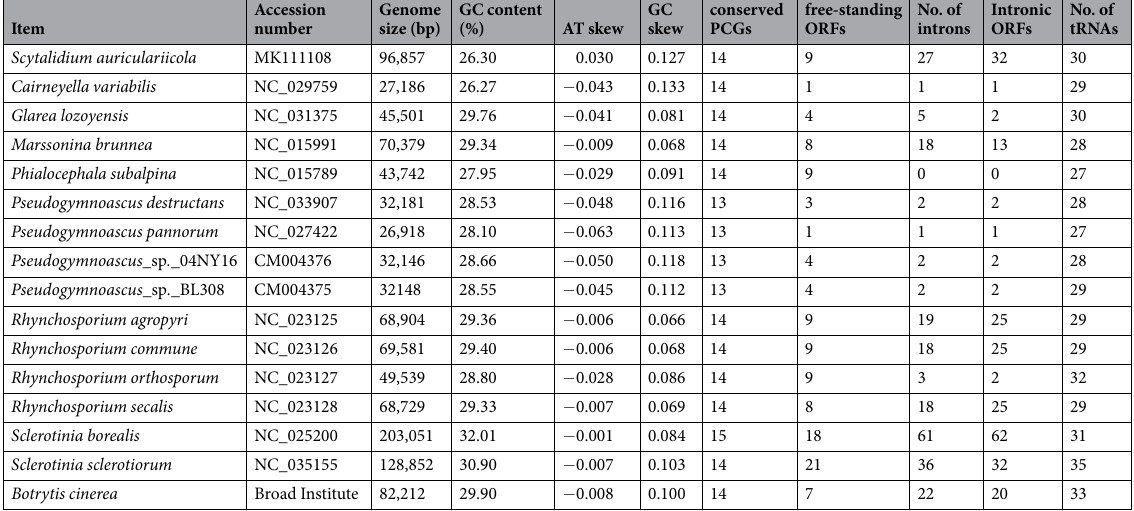
Table 1. Comparison of Leotiomycetes mitogenomes.